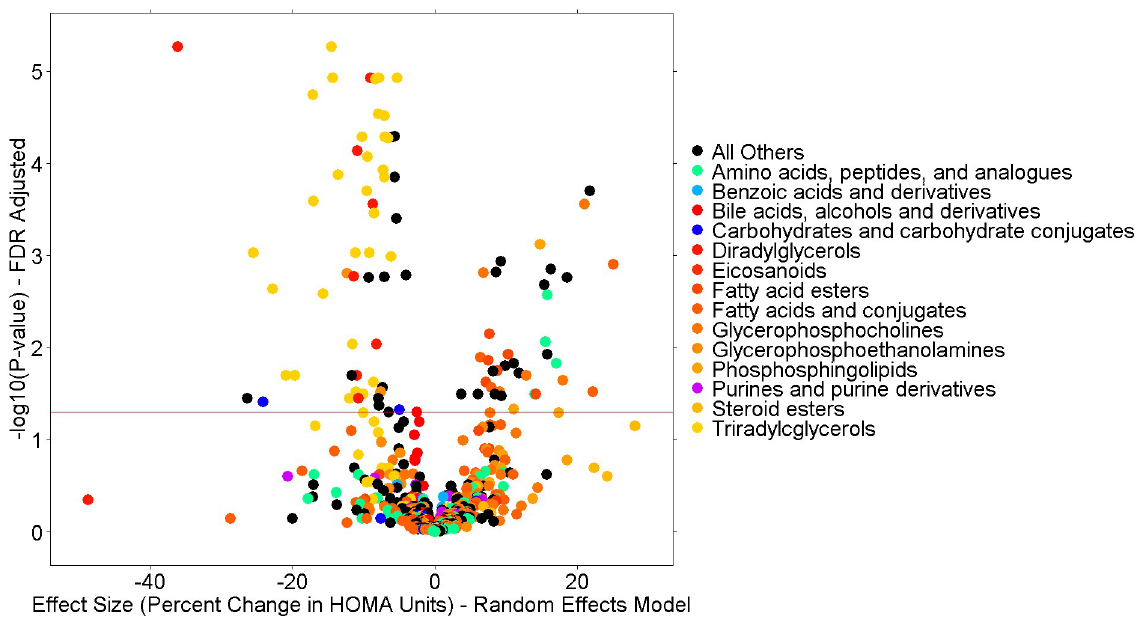
Fig 2. Meta-analysis of the univariate